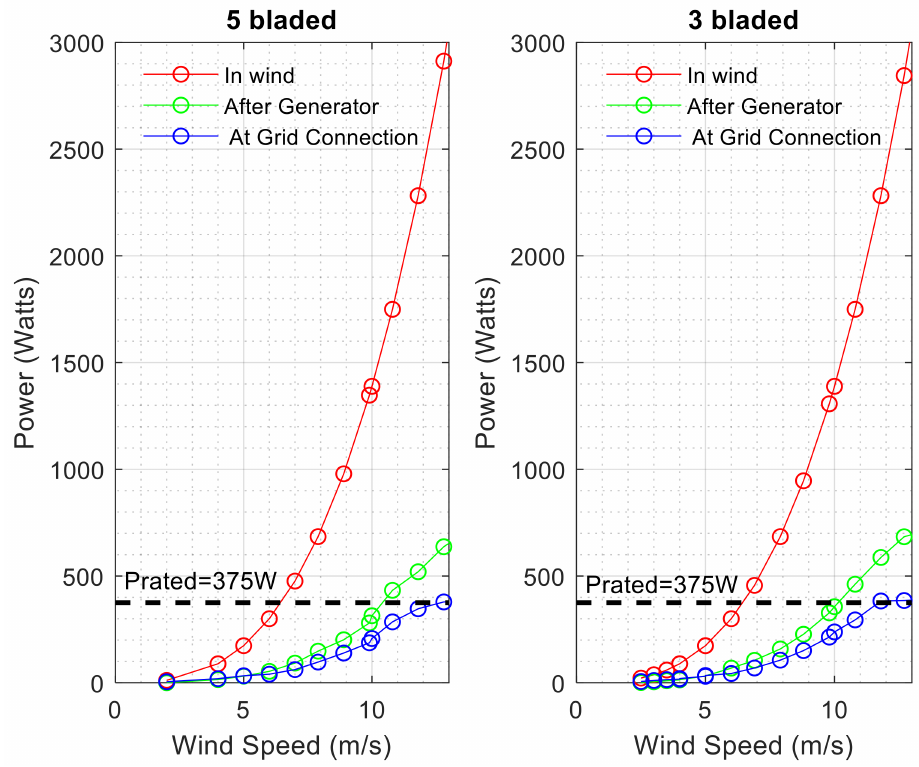
Figure 12. Available wind power ( red ), generated power ( green ), and delivered power to the grid ( blue